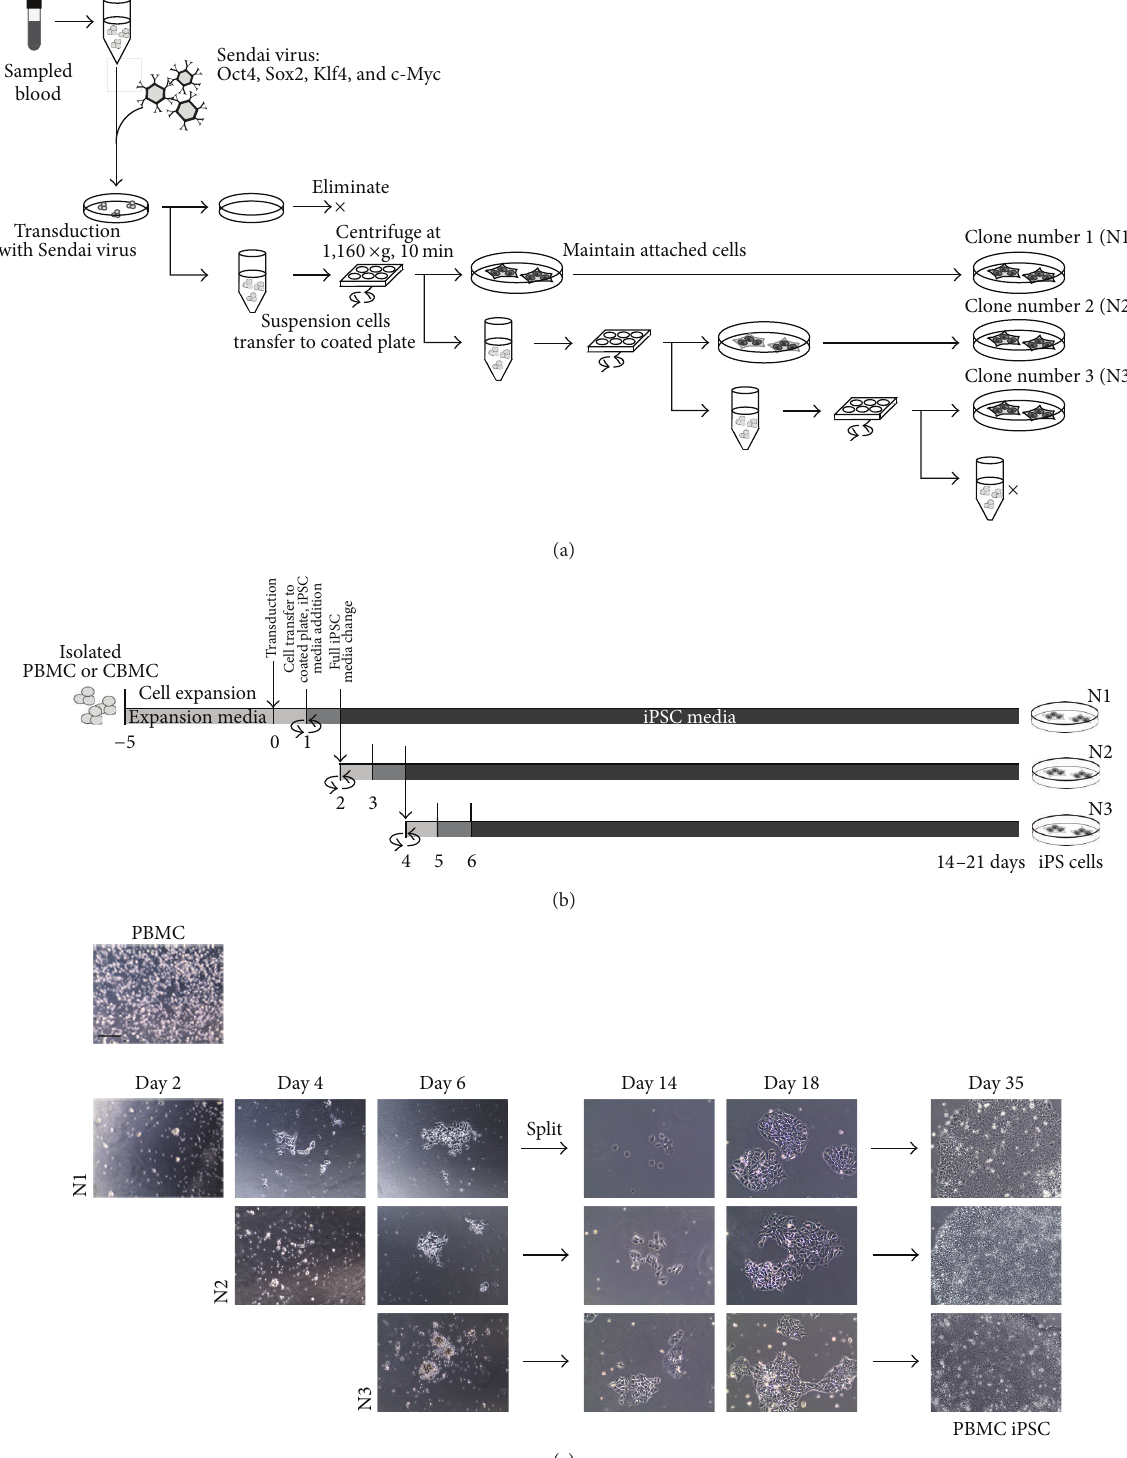
Figure 1: The scheme of the established protocol. (a) A detailed diagram of the designed protocol. (b) A simple scheme of the procedure over time based on medium type. (c) Brightfield image of generated cells. A greater number of colonies were obtained in a shorter amount of time. Scale bars: 200 𝜇